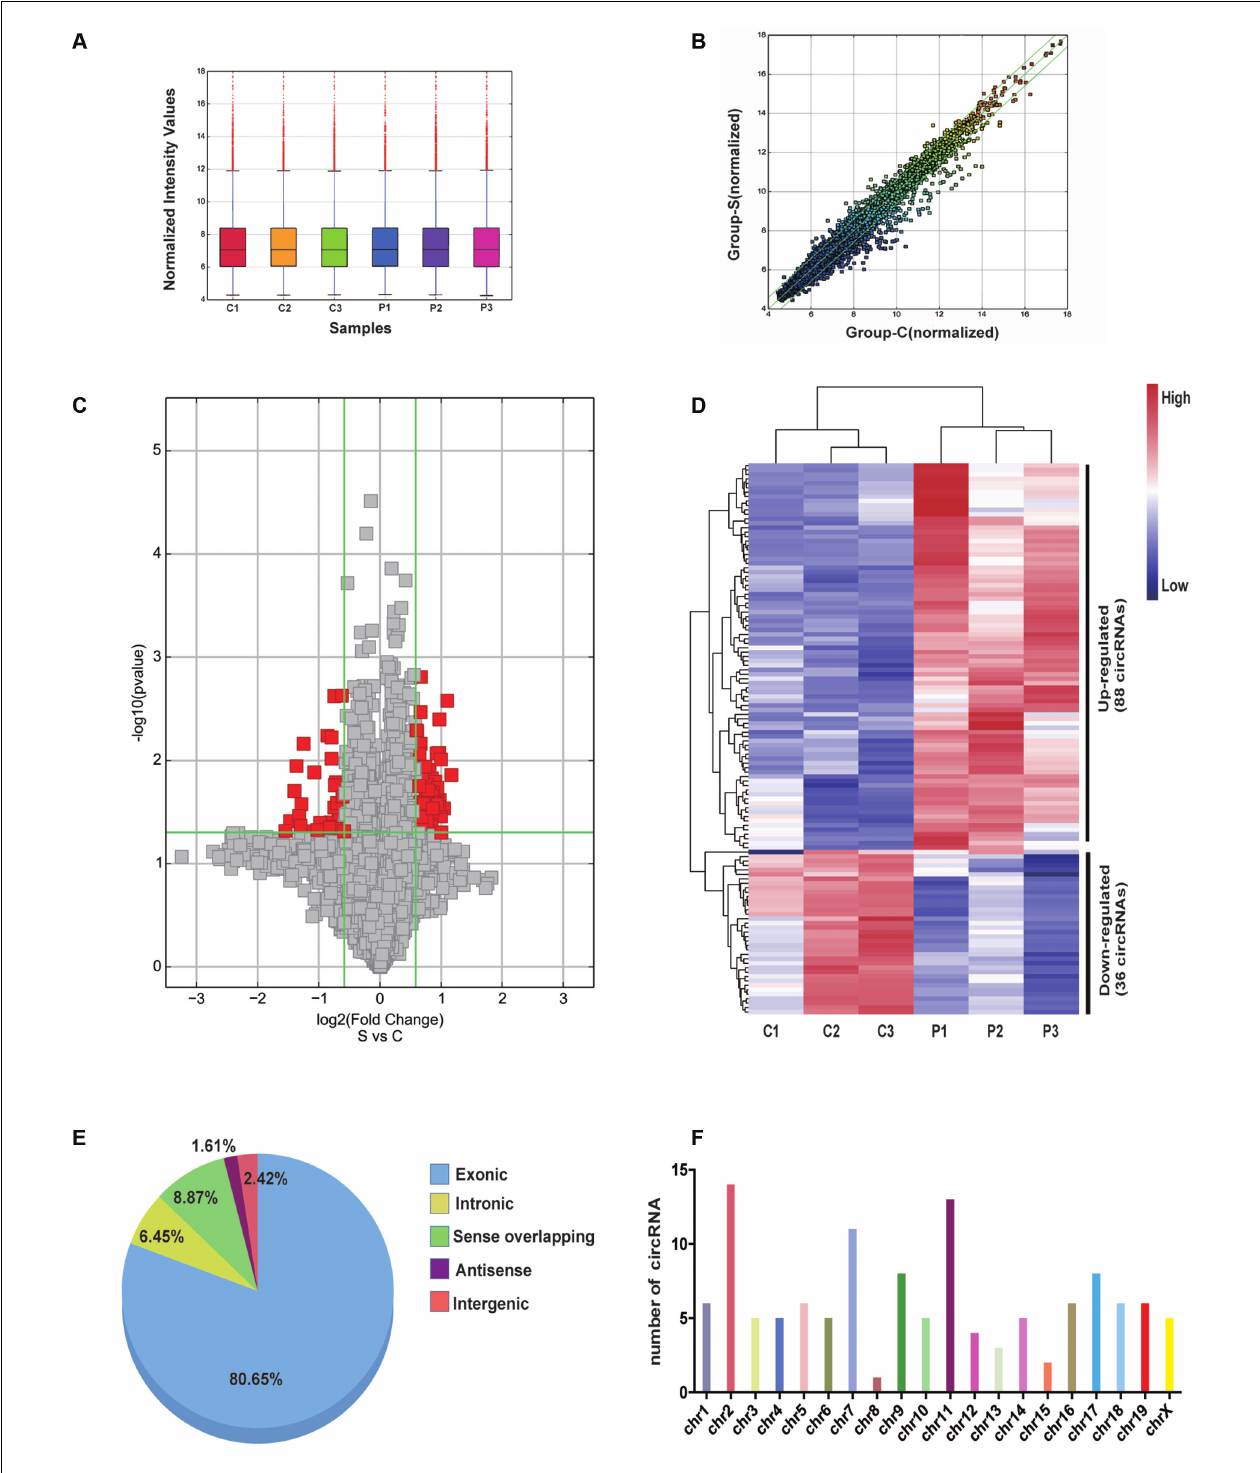
FIGURE 2 | Character of differentially expressed circRNA in the postoperative cognitive dysfunction (POCD) and control groups. (A) Distribution of circRNAs in the six samples (C1–3: control group; P1–3: POCD group). (B) The difference expression of circRNA is shown by a scatter plot between the control and POCD groups. (C) The differential circRNA expression is shown by volcano diagrams between the control and POCD groups. (D) Thirty-six downregulated and 88 upregulated circRNAs in POCD are shown in the heatmap. (E) The pie chart showed the transcriptional sources of the differentially expressed circRNAs. (F) Chromosome locations of the differentially expressed